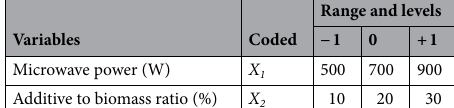
Table 2. Coded and actual values for the experimental ranges of independent